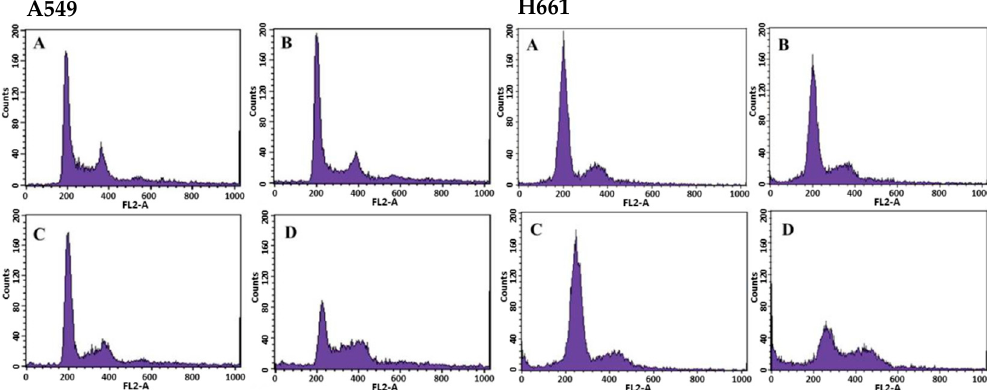
Figure 2. Cell cycle analysis of A549 and H661 cells treated with different concentrations of BSE by flow cytometry. The cells (1 × 10 6 cells) were incubated with: ( A ) 0 µ g/mL (Control), ( B ) 22 µ g/mL, ( C ) 44 µ g/mL, ( D ) 88 µ g/mL of BSE for 48 h. The percentage of each phase was analyzed by WinMDI 2.5 software. Table 2. Distribution of lung cancer cells arrested at different phases after the treatment of different BSE concentrations for 48 h *. BSE Conc. ( µ